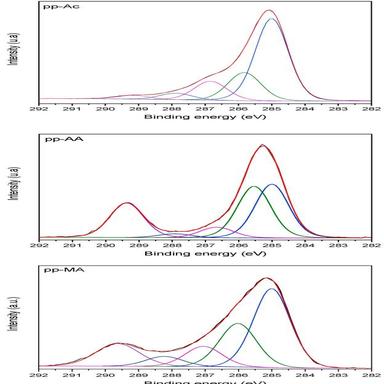
C 1s high resolution spectra of pp-Ac, pp-AA, pp-MA prepared in optimal operating parameters.